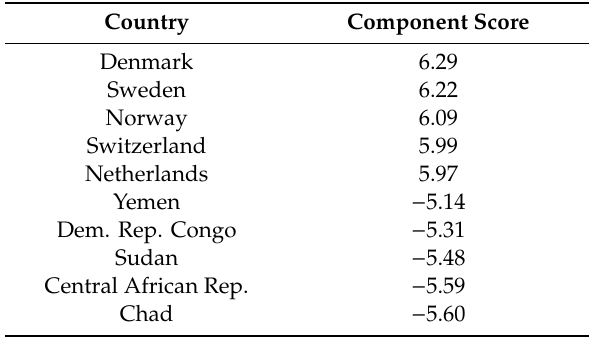
Table 4. Top five positive and negative component scores for Component 1.